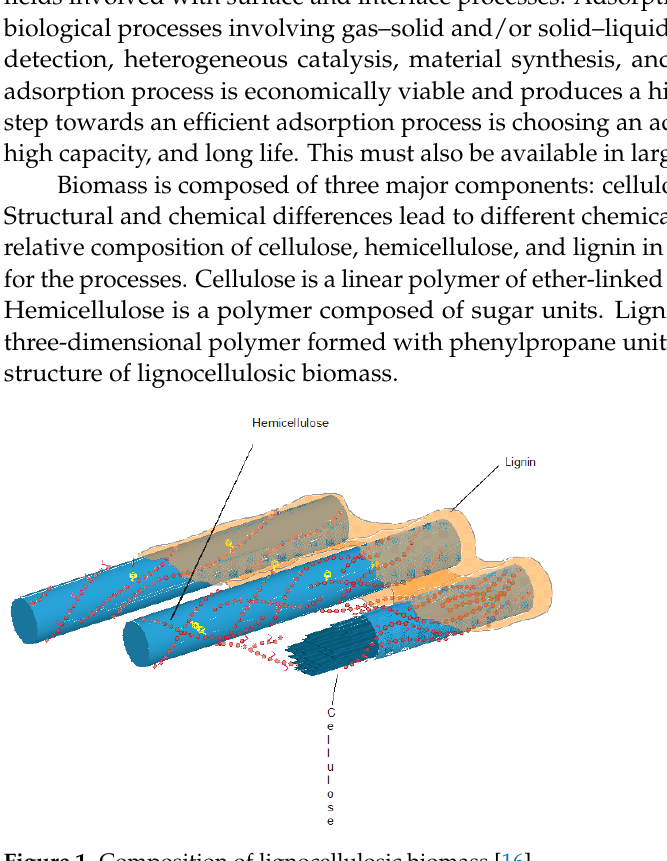
Figure 1. Composition of lignocellulosic biomass [16]. Lignocellulosic biomasses still have ash and moisture in their composition. The ash corresponds to inorganic constituents that mainly include SiO 2 , CaO, K 2 O, P 2 O 5 , Al 2 O 3